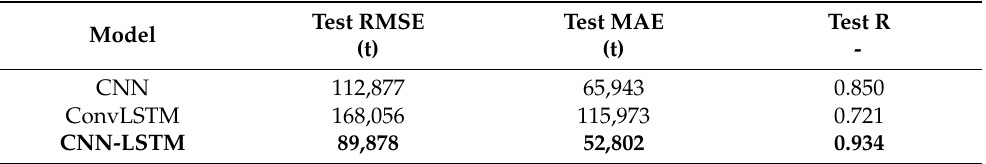
Table 1. Model performance of rice yield prediction measured by root mean square error RMSE, mean absolute error MAE and correlation coefficient R